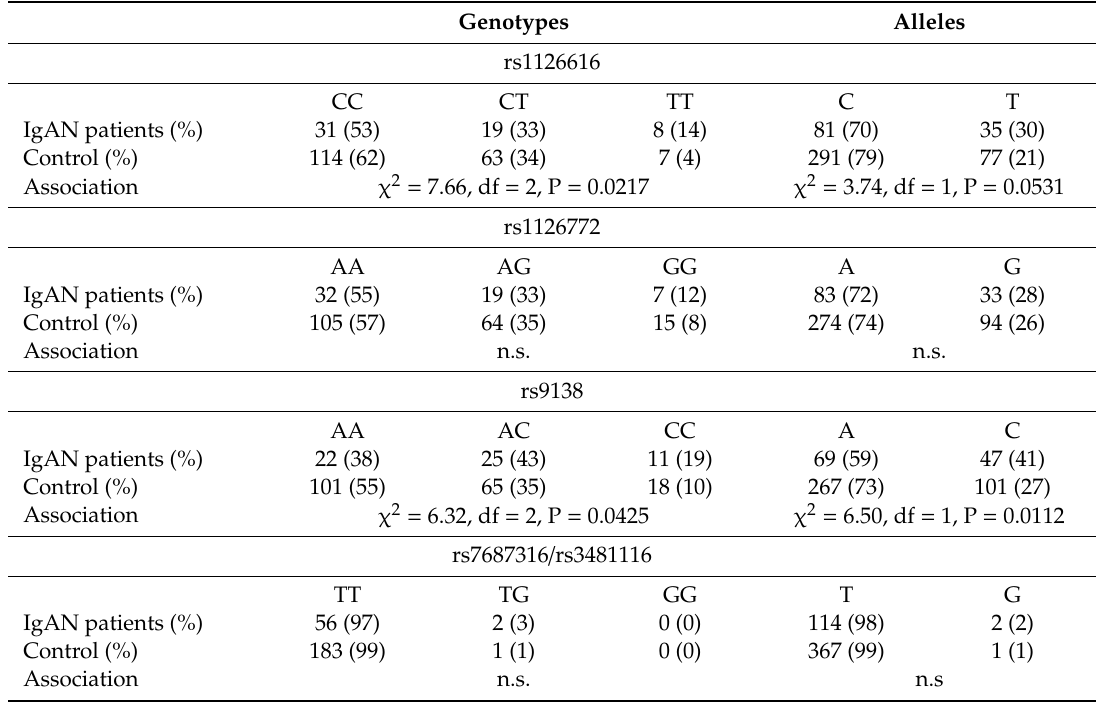
Table 2. Genotypes and alleles frequency of SPP1 rs1126616, rs1126772, rs9138, and rs7687316 / rs3481116 polymorphisms in IgAN patients and controls. Data are expressed as N